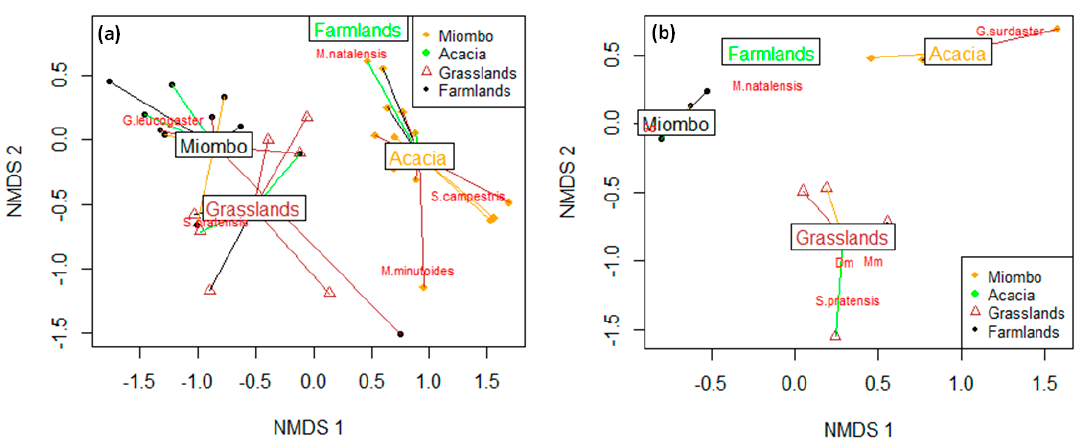
Figure 3. Species–habitat associations of rodent community in the Chembe Bird Sanctuary landscape, Zambia, in 2018–2019 in wet ( a ) and dry ( b ) seasons, respectively, derived from Non-metric Multi-Dimensional Scaling. The terminal points in Figure 3a,b reveal networks of different rodent samples in particular habitats. Line colours show the similarity of species presence in a particular habitat in relation to other habitats. In Figure 3b, Sc in Miombo woodland represents S . campestris , while Dm and Mm in grasslands represent D . melanotis and M . minutoides , respectively.